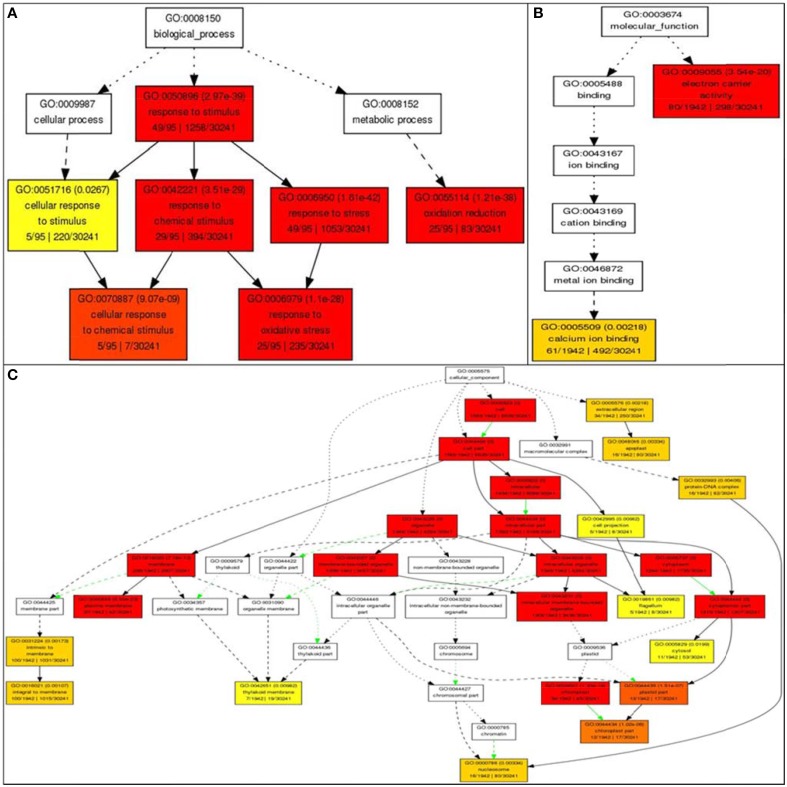
Gene Ontology enrichment of RGA1-regulated, stress responsive genes from Rice DB. The 1498 genes common to all four major abiotic stresses were subjected to GO enrichment using AgriGO with default settings. (A) Biological process categorization of the RGA1-regulated genes shared by salt, heat, cold, and drought stresses. (B) Molecular function categorization and (C) Subcellular localization of the RGA1-regulated genes shared by all four abiotic-stresses.